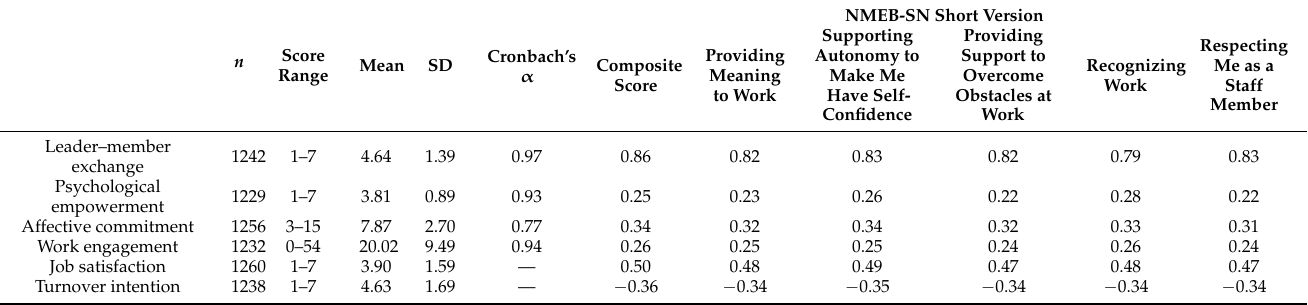
Figure 1. Confirmatory factor analysis of the NMEB-SN short version. Table 2. Descriptive statistics, Cronbach’s α , and Pearson’s correlation analysis of the NMEB-SN short